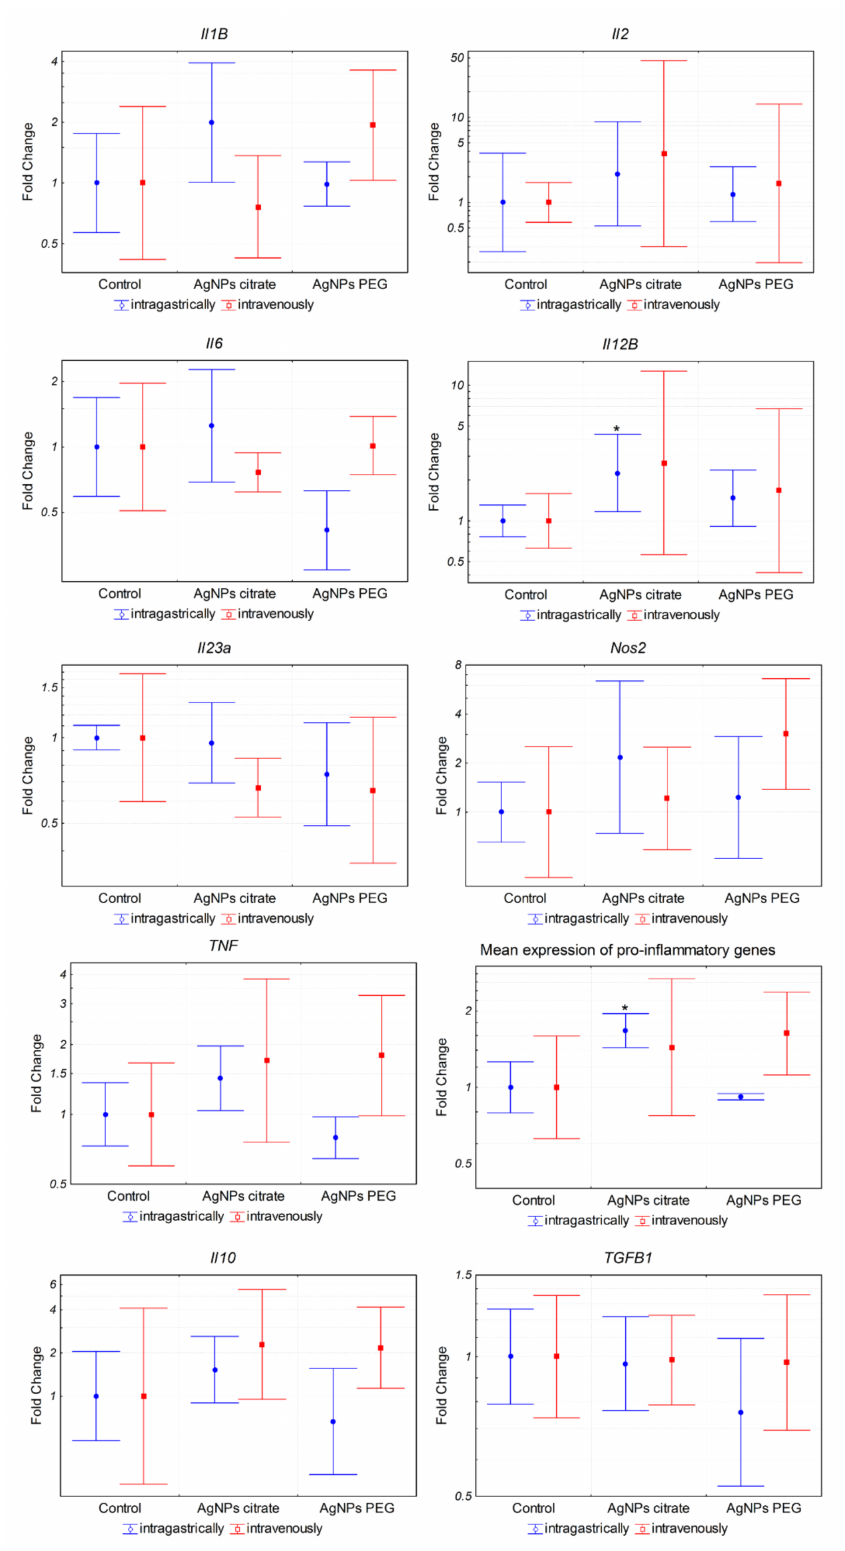
Figure 7. Expression of inflammation-related genes in tumor tissue from mice treated intragastrically or intravenously with 1 mg/kg citrate- or PEG-coated AgNPs. Markers represent mean fold change values and whiskers represent the minimum and maximum fold change calculated from a standard deviation of ∆ Ct values. * p < 0.05 difference versus control group, n =